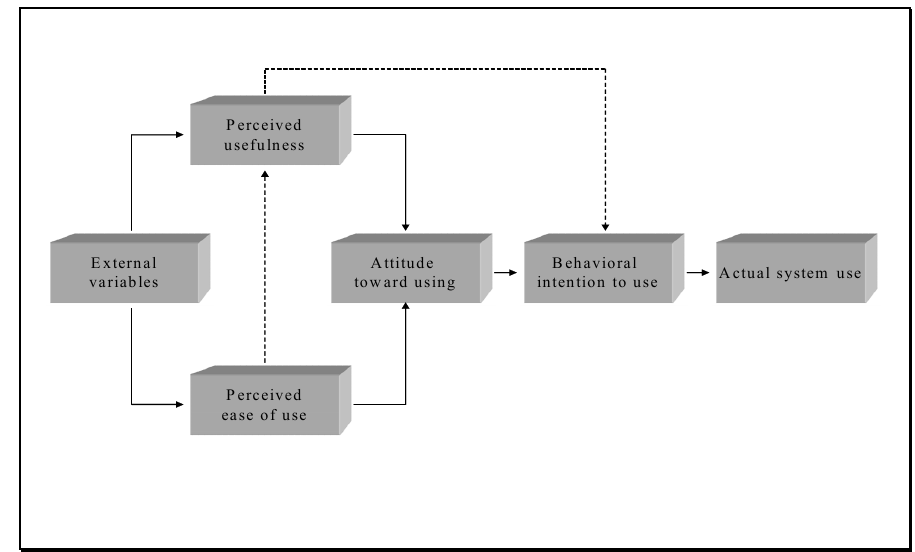
Figure 1. Technology Acceptance Model (TAM). Source: [48].